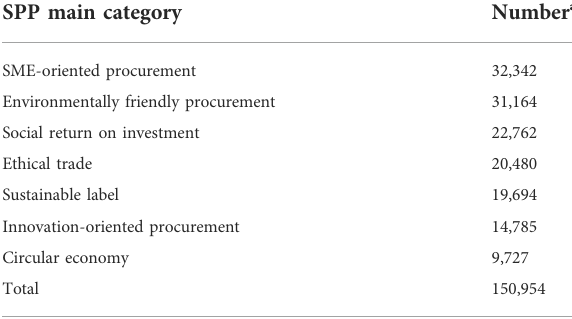
TABLE 3 SPP main category implementation ( n =